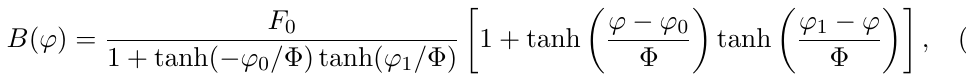
4 Edge e(cid:11)ects of static constant